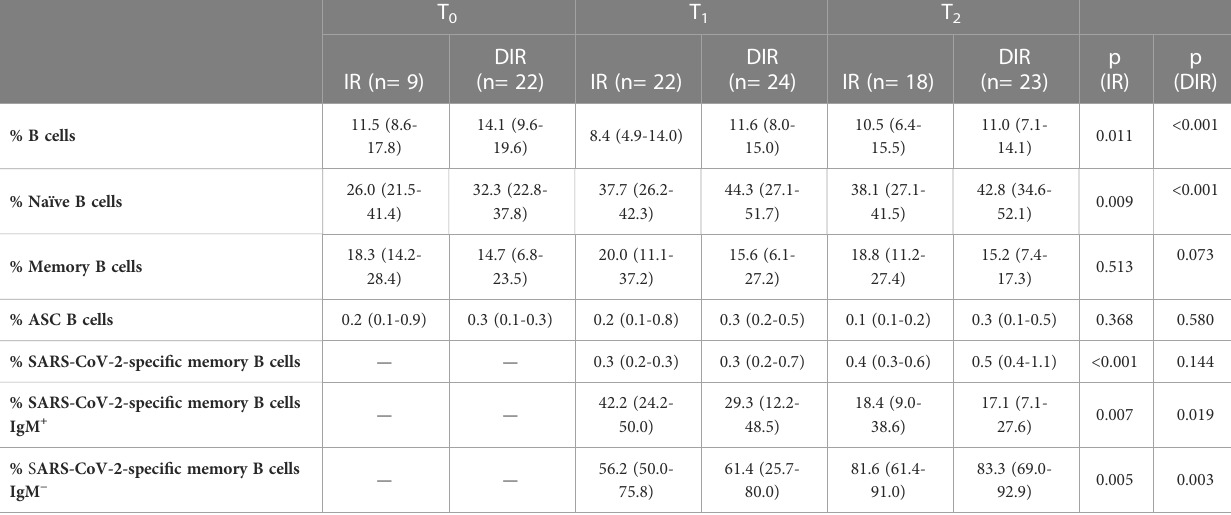
TABLE 3 B-cell phenotype in immune responders (IR) and discordant immune responders (DIR). T 0 T 1 T